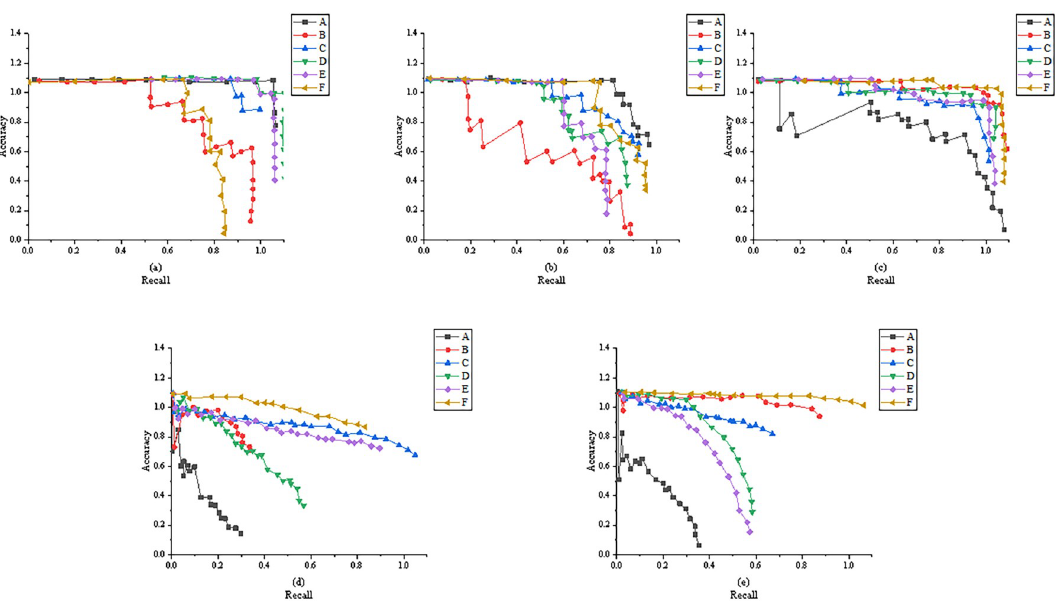
Fig 6. PR curves of different comparison algorithms on aircraft target data set (A: FRCN-ZF; B: FRCN-VGG; C: SSD; D: YOLO-v5; E: YOLO v1; F: YOLO-v5+ R-FCN; a: Berlin Brandenburg Airport Willy Brandt; b: Sydney Kingsford Smith Airport; c: Tokyo International Airport; d: John F. Kennedy International Airport; e: Toronto Pearson International Airport).